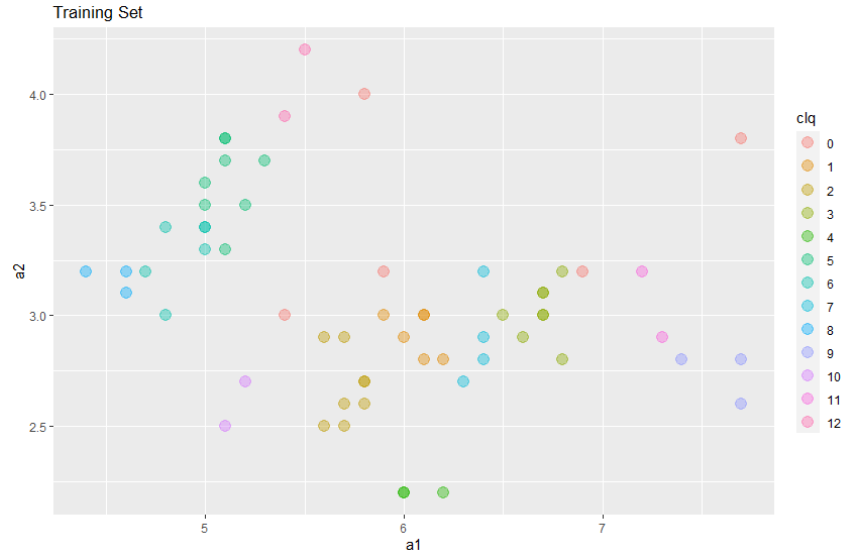
Figure 2. Clusters for sample